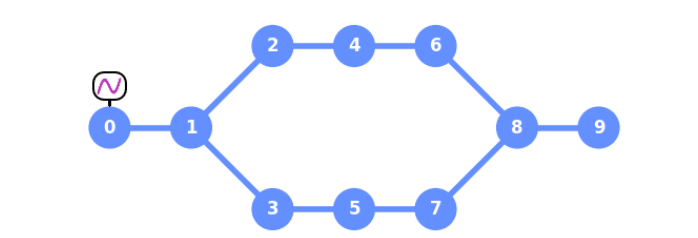
Figure 22: A plaquette with two edge qubits attached on opposite sides of a ring, containing ten qubits in total. The bonds indicate qubits interacting with with their nearest neighbors by a “flip-flop” (XY) interaction term as in Eq. (21). Qubit 0 is being driven periodically as in Eq.